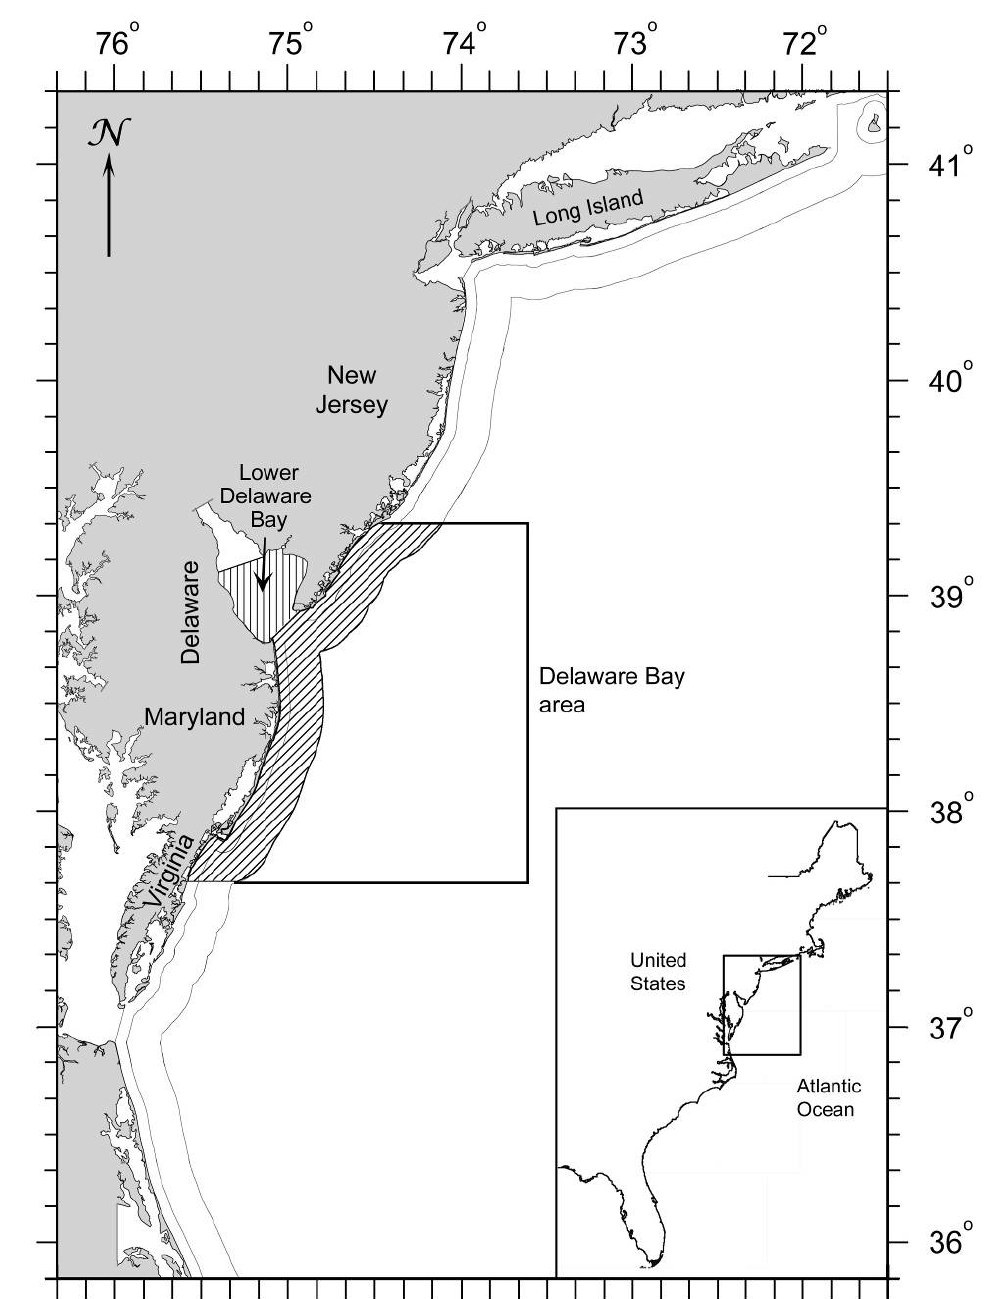
Figure 59. Virginia Tech trawl survey sampling area. The coastal Delaware Bay area (DBA) and Lower Delaware Bay (LDB) survey areas are indicated. Mean catches among years were compared using stations within the shaded portions of the survey area in the annual report (map provided by Virginia